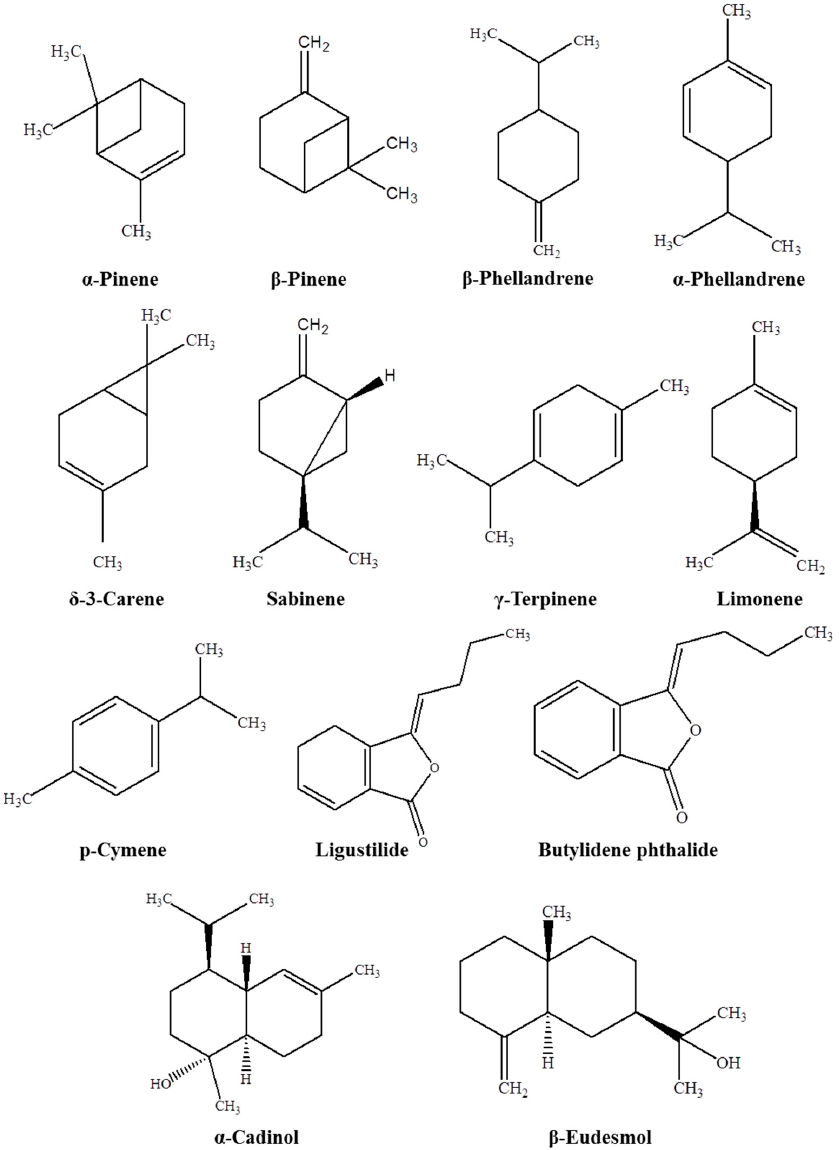
Figure 1. The chemical structure of some major essential oil components from Angelica species.